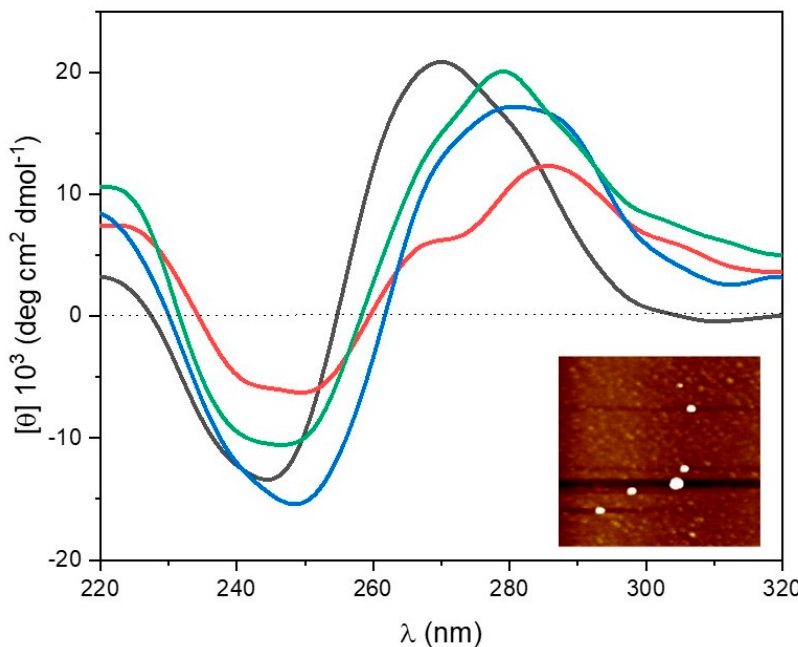
Figure 6. CD spectra of DNA (black), and in the presence of FGP6 (N/P = 1 red, N/P = 0.5 blue, N/P = 0.25 green). In the insert: AFM image for N/P = 0.5 from ref. [18].